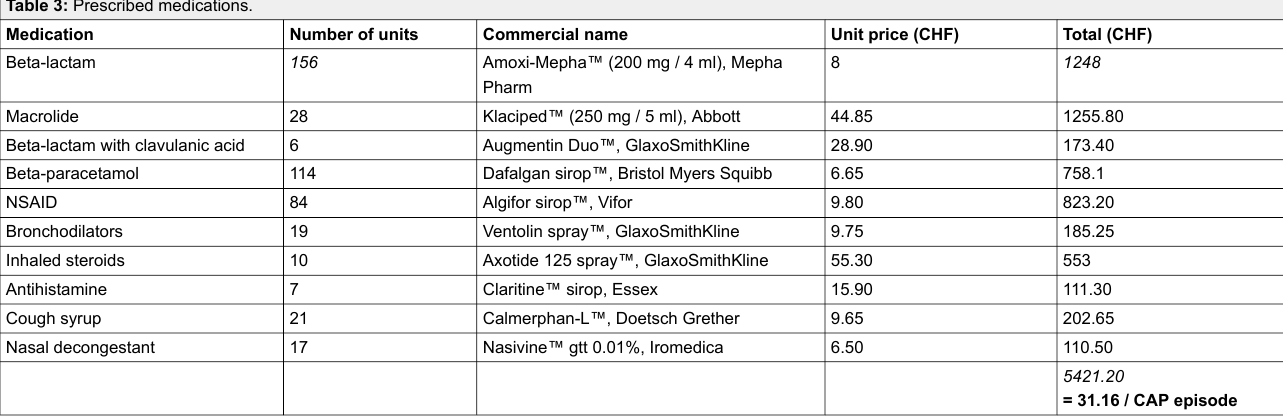
Table 3: Prescribed